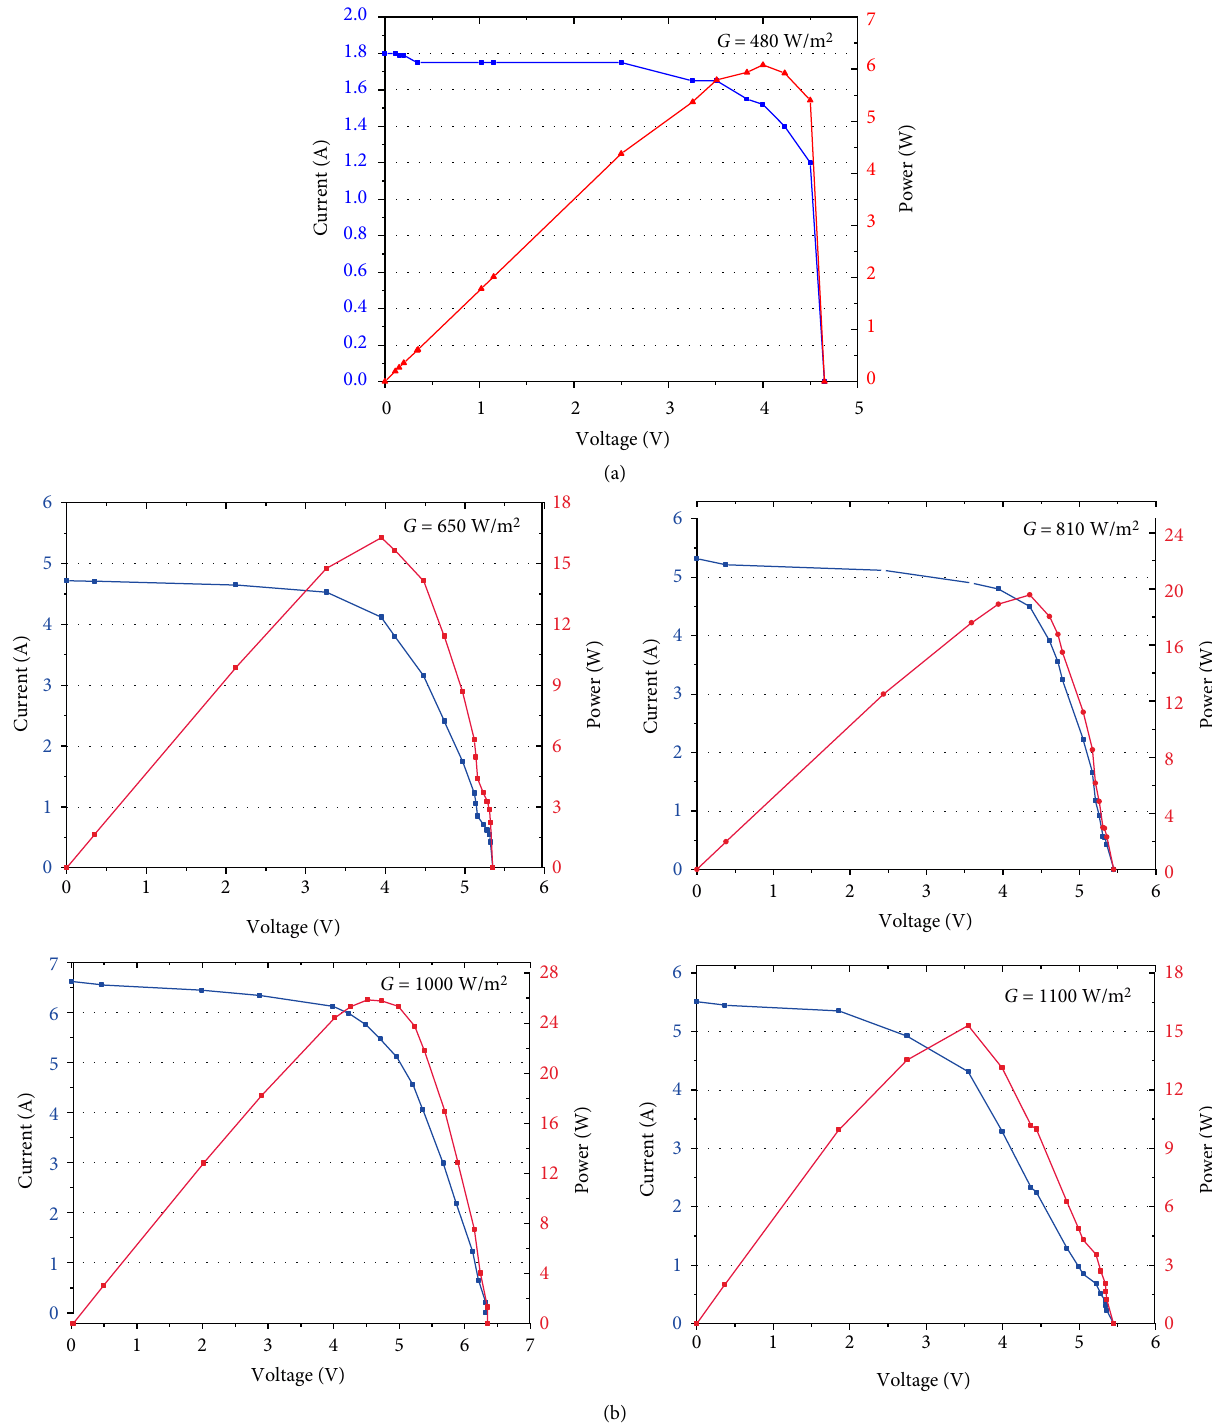
Figure 7: The semi-transparent solar panel performance at different irradiances: I-V and P-V